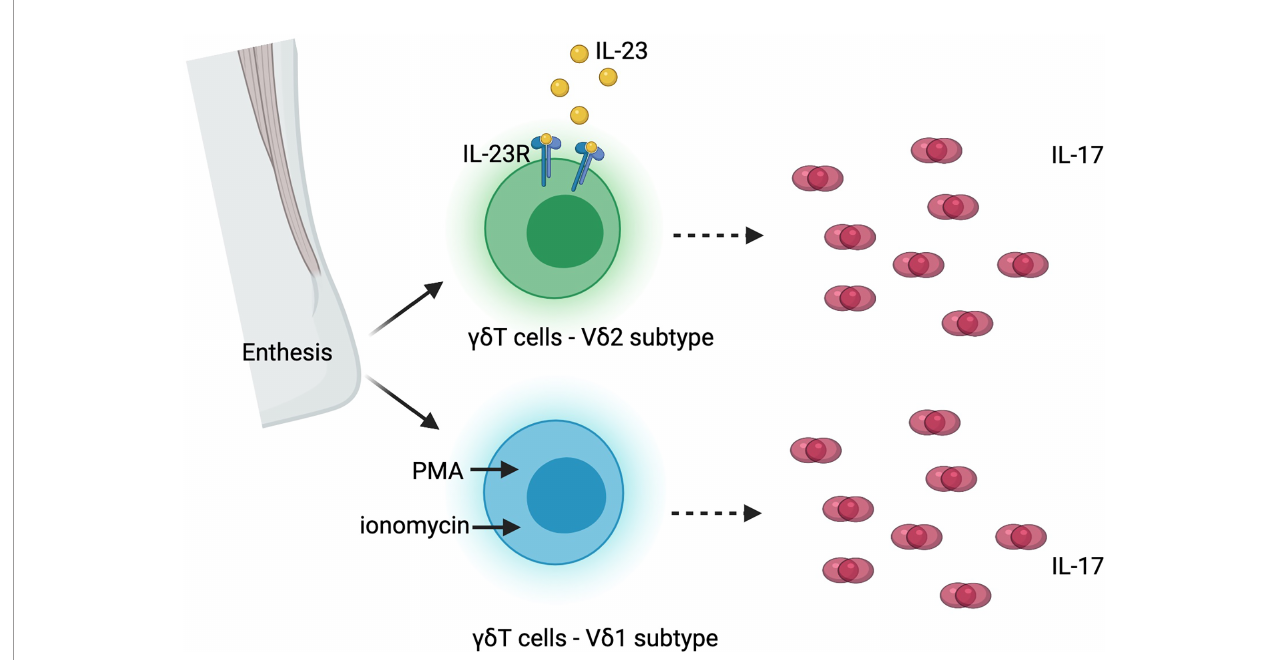
FIGURE 3 | Co-existence of interleukin-23 (IL-23) dependent and independent interleukin-17 (IL-17) production in human enthesis. PMA, phorbol 12-myristate 13-acetate; IL-23R, interleukin-23